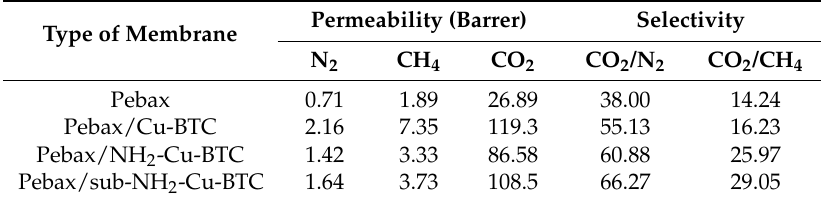
Table 2. Gas permeability and CO 2 /N 2 and CO 2 /CH 4 selectivity of the prepared membranes. Permeability (Barrer) Type of Membrane